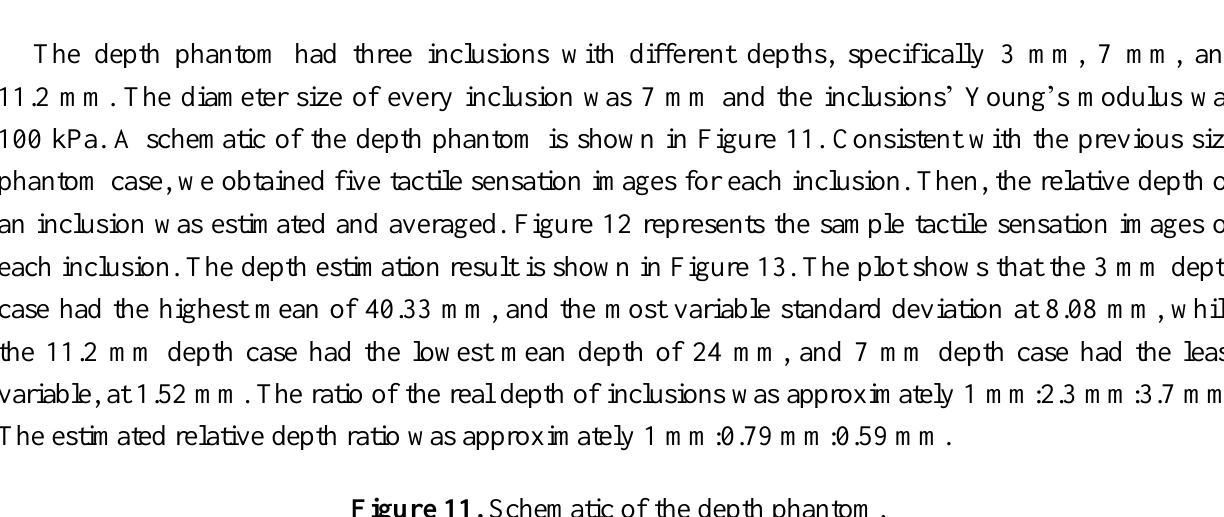
Figure 11. Schematic of the depth phantom.